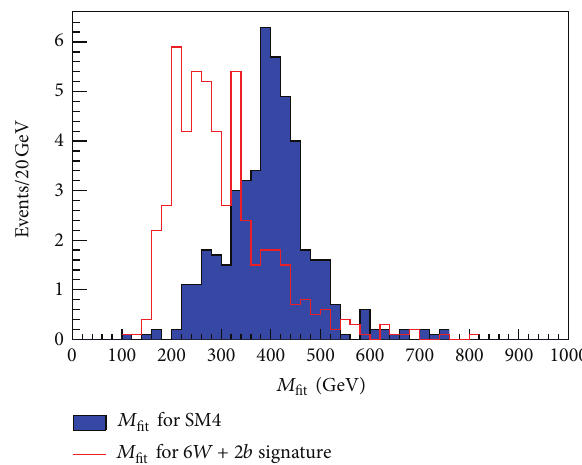
Figure 18: 𝑀 distribution for the SM4 2𝑊 + 2𝑏 → 𝑙 ] 𝑏𝑏𝑞𝑞 fit signature (blue) and for the 4G2HDMI 6𝑊 + 2𝑏 signature (red), for a set of 7TeV LHC events with ∫𝐿𝑑𝑡 = 1𝑓𝑏 −1 . For both signatures, = 450 GeV is assumed. The peak of the distribution of 𝑀 𝑚 𝑡 󸀠 the SM4 signature is around 𝑚 𝑡 󸀠 , while for the new signature the peak is shifted to a significantly lower value coinciding with the peak of the 𝑡𝑡 background. Figure taken from